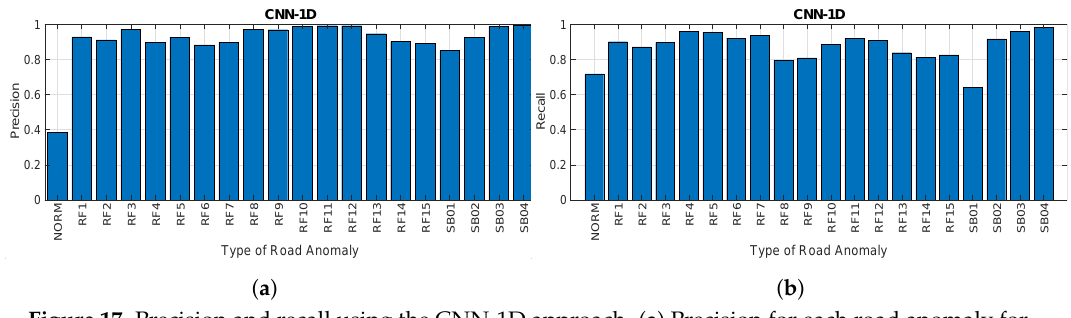
Figure 17. Precision and recall using the CNN-1D approach. ( a ) Precision for each road anomaly for CNN-1D (sampling rate of 50 Hz) and ( b ) recall for each road anomaly for CNN-1D (sampling rate of 50 Hz).